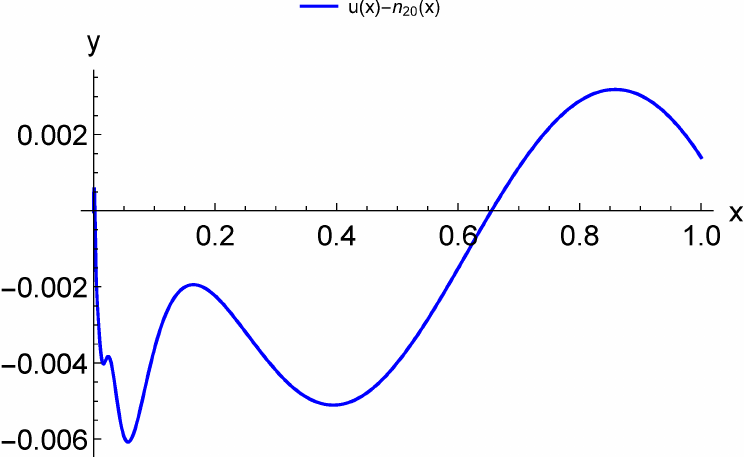
Figure 8. Plots of the error of neural network solution n 20 ( x ) (9) (number of layers n = 20; sigmoid activation functions) as applied to problem (30), parameter value s =